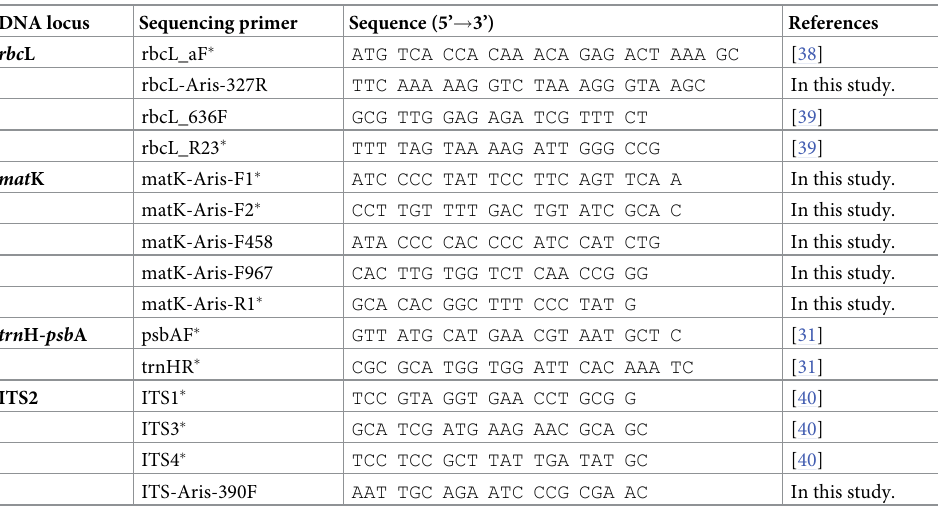
Table 2. Primers used for DNA barcode generation.